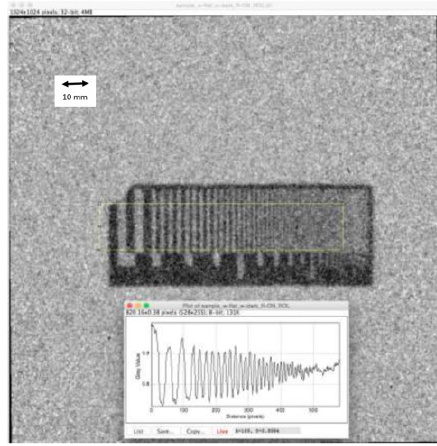
Fig. 1. Example image obtained at 8x10 3 n/cm 2 s in 30 min (AKR-2, TU Dresden); image courtesy C. Lange, TU Dresden,